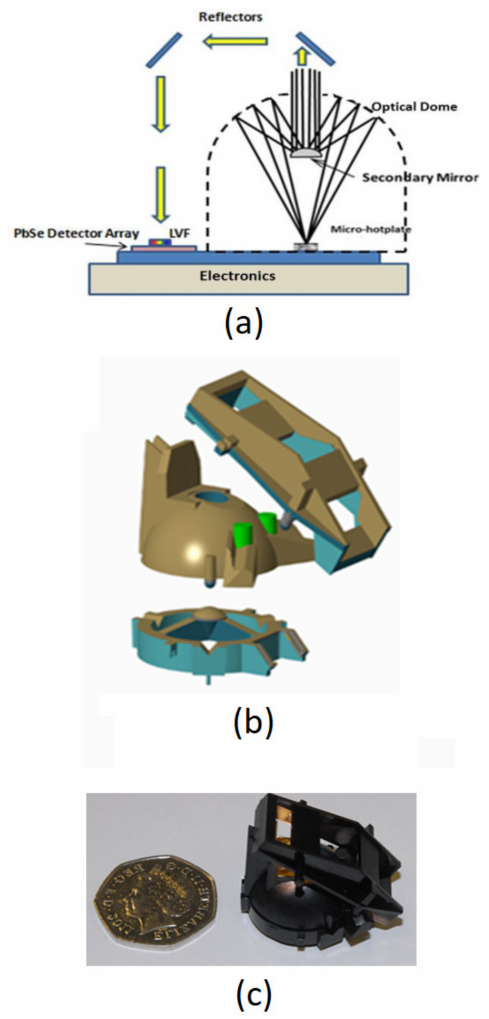
Figure 1. ( a ) Schematic of the multi-gas sensor optics; ( b ) exploded view of the three-piece optical assembly; ( c ) assembled injection moulded optics (UK 50 pence piece shown for scale—23 mm